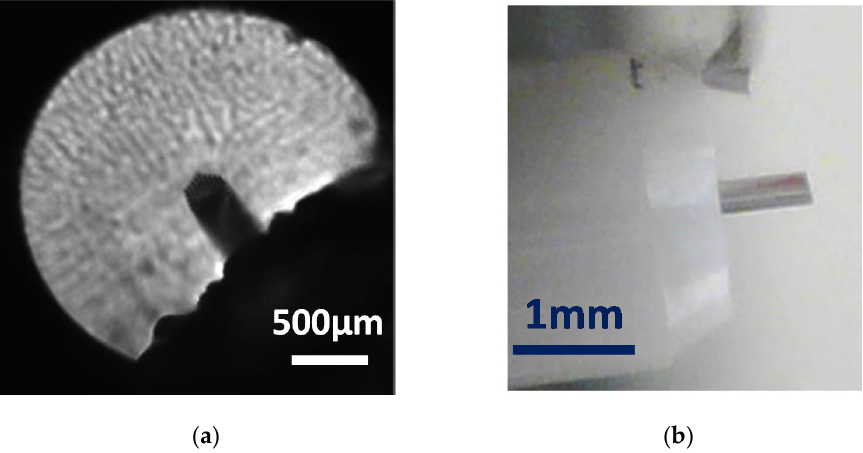
Figure 5. Pictures of one mPOF sample connectorized to a FC connector before automated cleav- ing testing. ( a ) Top view, ( b ) Lateral view. testing. ( a ) Top view, ( b ) Lateral